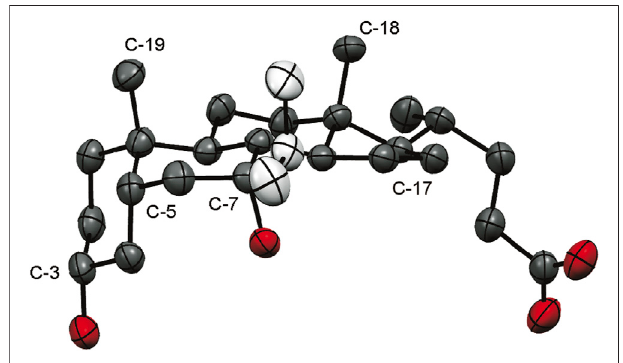
FIGURE 2 | An ORTEP (Farrugia, 2012) view of 2 h (7 β -isopropyl- CDCA), displacement ellipsoids are shown with 50% probability. Oxygen – red, steroid carbon skeleton – black, isopropyl moiety –